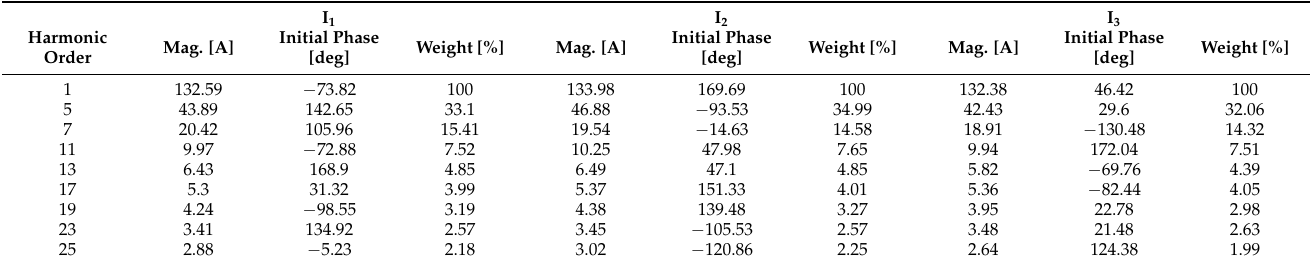
Table 2. Parameters of the most significant harmonics of the phase currents—before compensation, case γ .